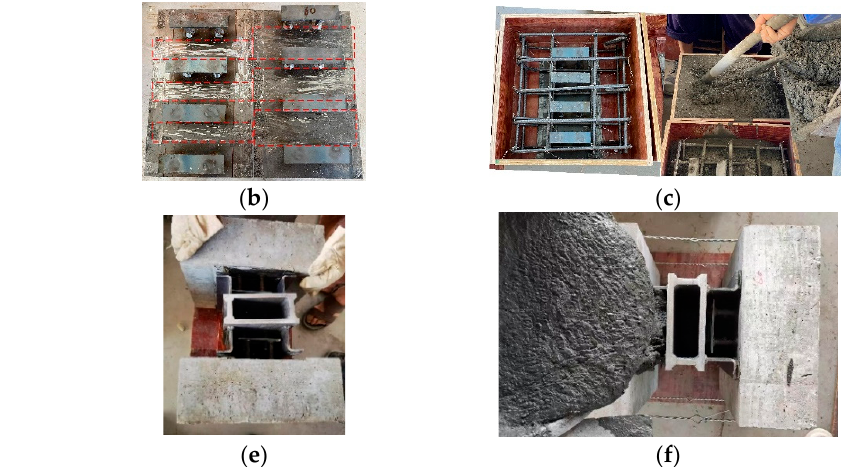
Figure 6. Fabrication procedures of specimen: ( a ) Formwork of precast slab; ( b ) Defect arrangement; ( c ) Casting concrete; ( d ) Welding stud; ( e ) Assemble; ( f ) Pouring connection concrete.